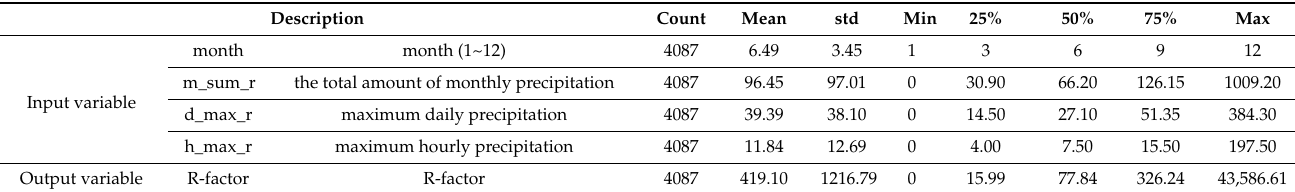
Table 3. The input data for machine learning